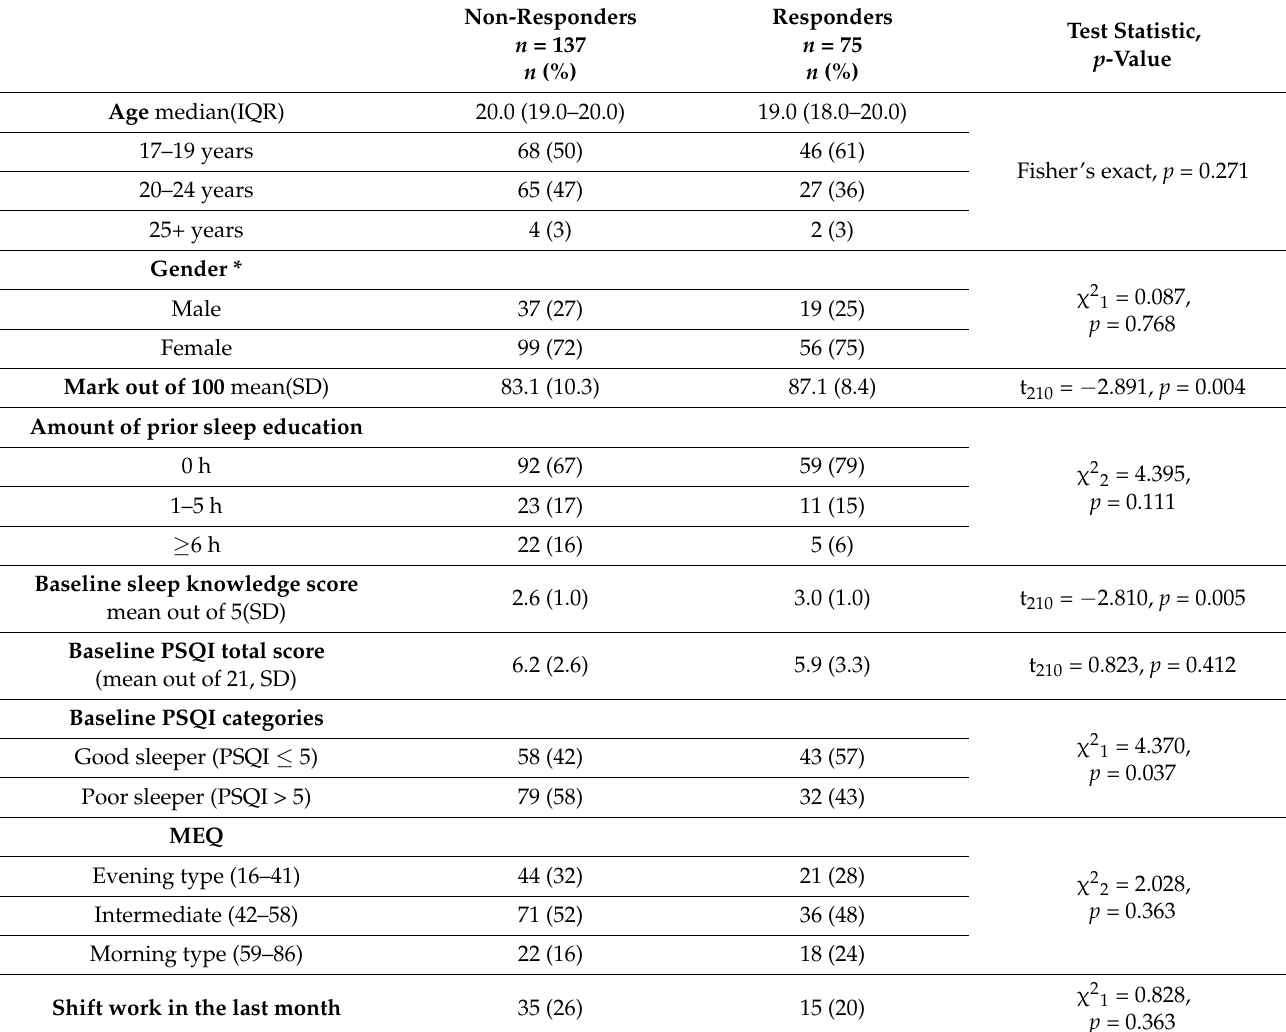
Table 1. Characteristics of students who completed the baseline survey only, and those who additionally completed the follow-up survey.